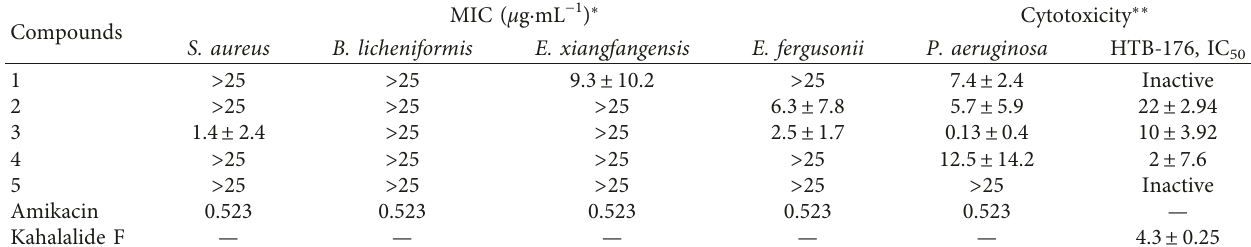
Table 3: Bioactivities of tested compounds 1 – 5 .